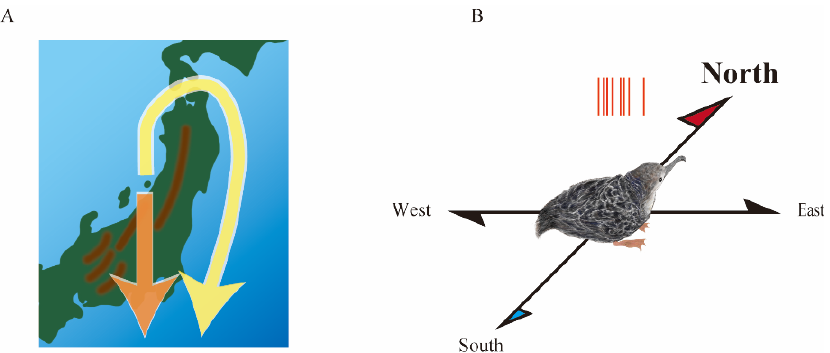
Figure 4. Neurologger connects neuroscience and ecology. ( A ) Fledgling chicks of a migratory bird crossed steep mountain ranges to reach the ocean during the first migration (orange arrow), whereas adults bypassed mountain ranges and flew along the coastlines (yellow allow). ( B ) Head direction cells in the medial pallium of migratory bird chicks preferentially generate action potentials (red bars) when the head faces the geomagnetic